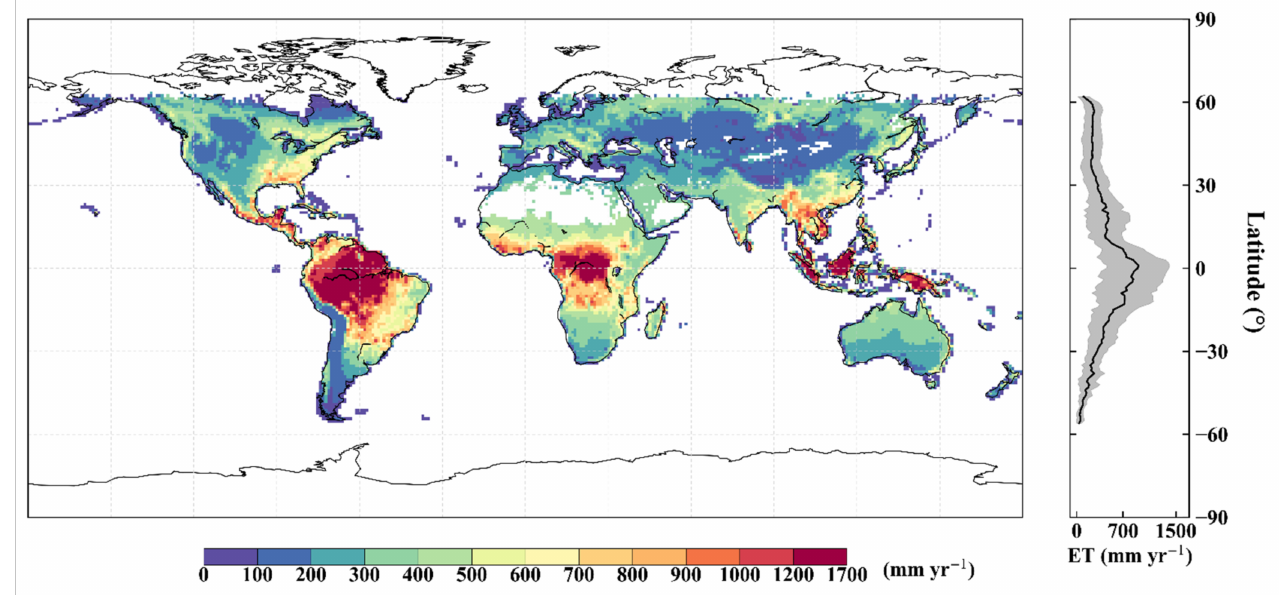
Figure 5. Global ET map of Case I in 2015 simulated by the BEPS model. The ET averaged over the global land surface is 511.9 ± 70.1 mm yr − 1 , where the uncertainty ± 70.1 mm yr − 1 is the sum of the uncertainty ( ± 26.7 mm yr − 1 ) resulting from the input vegetation data as well as model parameters, and the standard deviation ( ± 43.4 mm yr − 1 , Figure 8) of the annual global ET during 2013 to 2016 resulting from meteorological variations. The uncertainty from meteorological variations is calculated using the same model parameters and the same LAI and CI input dataset in 2015 but actual hourly meteorological data from 2013 to 2016. The uncertainty resulting from the input vegetation data and model parameters is approximated by the range of global terrestrial ET variation caused by LAI uncertainty of 20% (see Table 2)